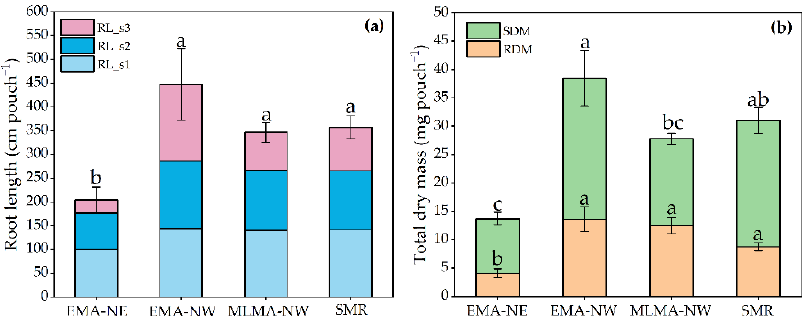
Figure 3. Variation of root length and total dry mass in 4 ecological regions: ( a ) root length in three layers and ( b ) shoot dry mass and root dry mass. Root data are the means for each ecological region. Root lengths in Section 1 (RL_S1, 0–5 cm), Section 2 (RL_S2, 5–10 cm), Section 3 (RL_S3, >10 cm) ± SE of total root length of all sections are presented. Ecological regions are ordered by the geographic location from north to south. Data are in mean ± SE. Bars of total root length or total root mass folled by different letters are significantly different, respectively ( p < 0.05).